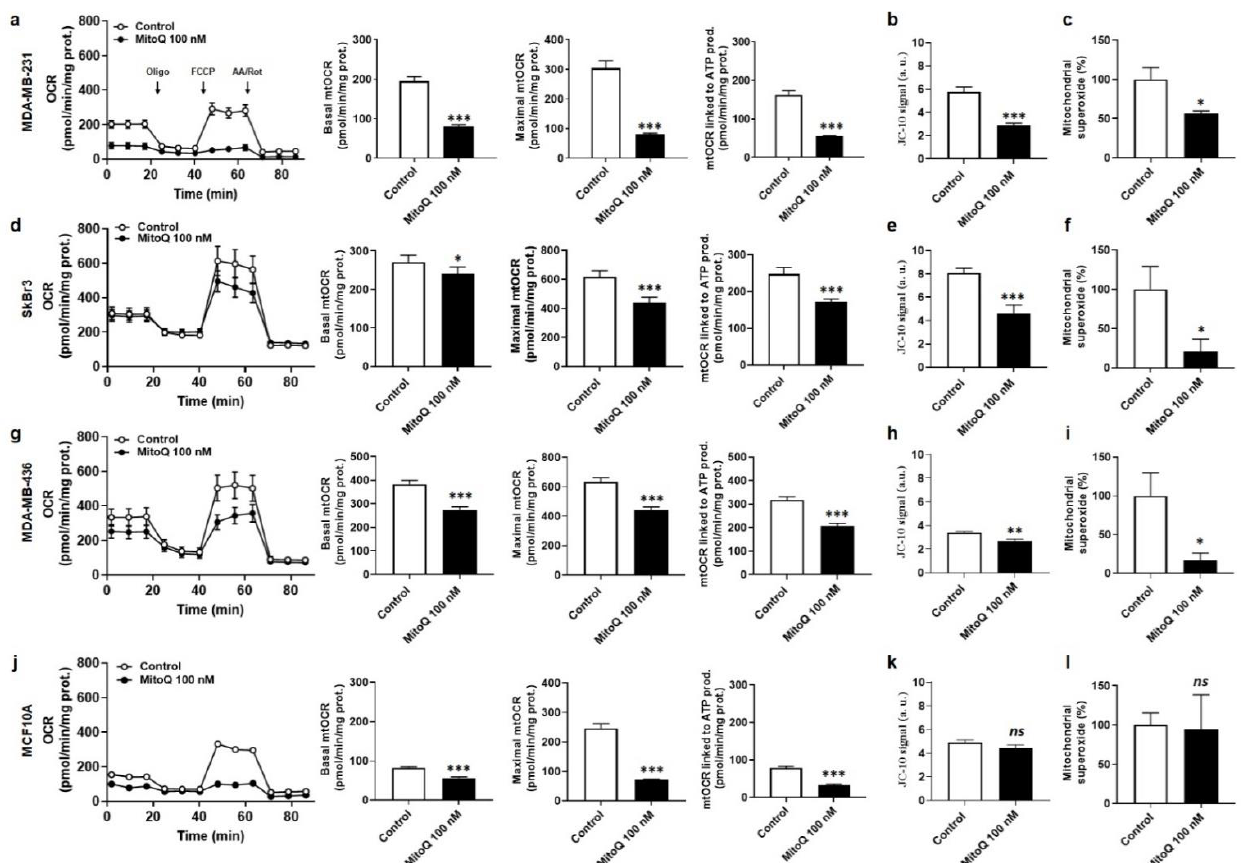
Figure 2. MitoQ selectively represses mitochondrial superoxide production by human breast cancer cells. Cells were treated ± MitoQ 100 nM for 48 h. ( a ) The oxygen consumption rate (OCR) of MDA- MB-231 cells was measured using Seahorse oximetry. The graph represents OCR measurements over time with the sequential addition of oligomycin, FCCP, and rotenone (Rot) together with antimycin A (AA). From Seahorse traces, basal, maximal and ATP-linked mitochondrial oxygen consumption rates (mtOCRs) were calculated ( n = 8–18). ( b ) The mitochondrial potential ( ∆ ψ ) of MDA-MB-231 cells was measured using JC-10 ( n = 16). ( c ) Mitochondrial superoxide (mtO 2 − ) levels were measured using electron paramagnetic resonance (EPR) with MitoTEMPO-H as a selective mtO 2 − sensor ± PEG-SOD2 ( n = 6). ( d ) Seahorse oximetry as in a, but using human SkBr3 breast cancer cells ( n = 29–41). ( e ) ∆ ψ measurement as in b, but using SkBr3 cells ( n = 16). ( f ) Determination of mtO 2 − levels as in c, but using SkBr3 cells ( n = 4). ( g ) Seahorse oximetry as in a, but using human MDA-MB-436 breast cancer cells ( n = 16). Note that SEMs are smaller than symbols in the left graph showing oximetry traces. ( h ) ∆ ψ measurement as in b, but using MDA-MB-436 cells ( n = 8). ( i ) Determination of mtO 2 − levels as in c, but using MDA-MB-436 cells. ( n = 4). ( j ) Seahorse oximetry as in a, but using nonmalignant MCF10A human breast epithelial cells ( n = 18–24). ( k ) ∆ ψ measurement as in b, but using MCF10A cells ( n = 8). ( l ) Determination of mtO 2 − levels as in c, but using MCF10A cells ( n = 3). All data are shown as means ± SEM. * p < 0.05, ** p < 0.01, *** p < 0.001 compared to control; ns : p > 0.05 compared to control; by Student t -test ( a – l